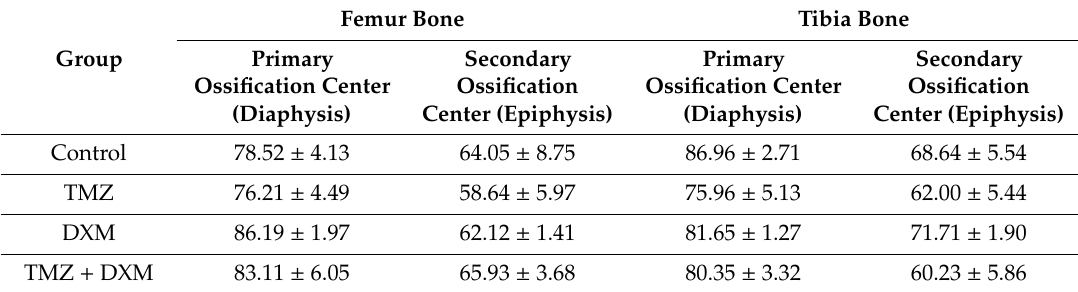
Table 2. The percentage of bone marrow in the epiphysis and diaphysis of the knee joint Wistar rat bones.All data are expressed as mean ± SD (ORIGIN 8.5 software). TMZ—temozolomide,